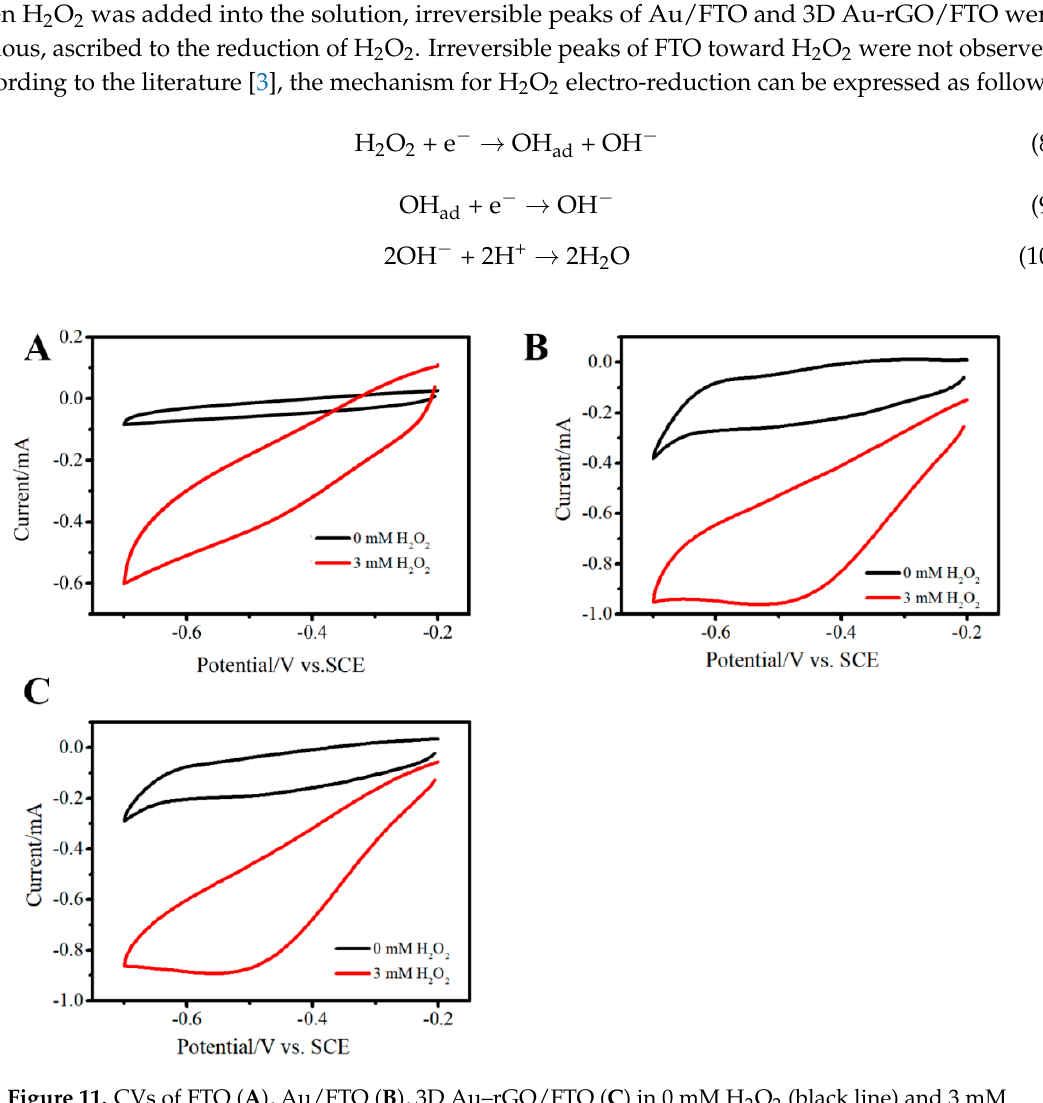
Figure 11. CVs of FTO ( A ), Au/FTO ( B ), 3D Au–rGO/FTO ( C ) in 0 mM H 2 O 2 (black line) and 3 mM H 2 O 2 (red line) in PBS. Scan rate: 100